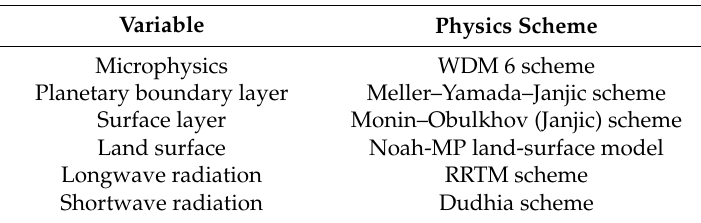
Table 2. WRF physics schemes used in this